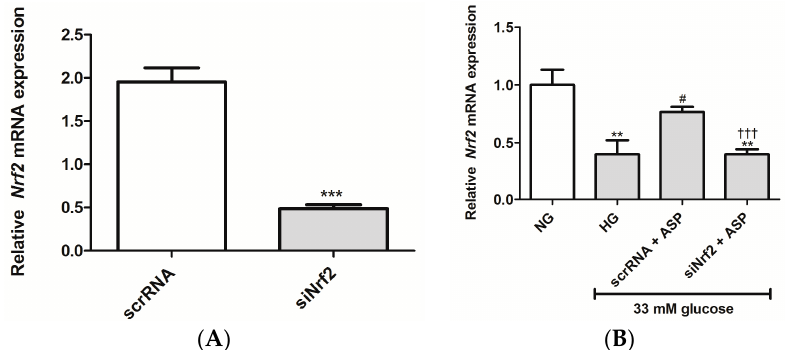
Figure 1. Aspalathin (ASP) increased the expression of Nrf2 in H9c2 cardiomyocytes. ( A ) The degree of Nrf2 knockdown in H9c2 cardiomyocytes after transfection with either small interfering RNA (siNrf2) or scrambled RNA (scrRNA) for 24 h; ( B ) H9c2 cardiomyocytes transfected with siNrf2 or scrRNA for 24 h were exposed to 33 mM glucose (HG) for 24 h, followed by treatment with 1 µM ASP for 6 h. Results are expressed as the mean ± SEM of three independent biological experiments relative to the normal glucose (NG) control, each done in triplicate. ** p ≤ 0.001, *** p ≤ 0.0001 vs. NG, # p ≤ 0.05 vs. HG, ††† p ≤ 0.0001 vs. scrRNA + ASP.